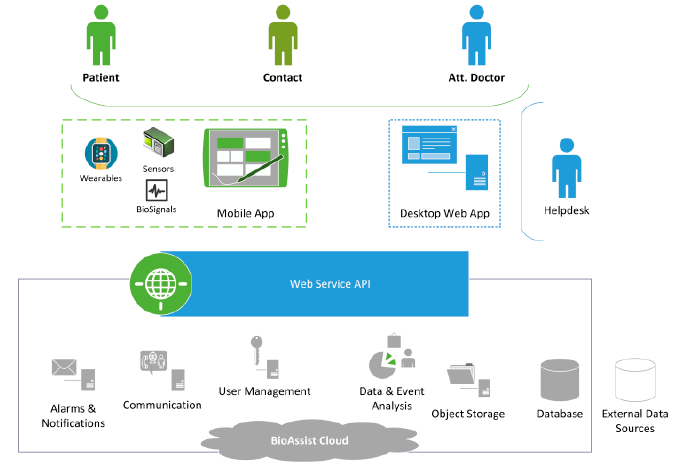
Figure 1. “HeartAround” Environment.